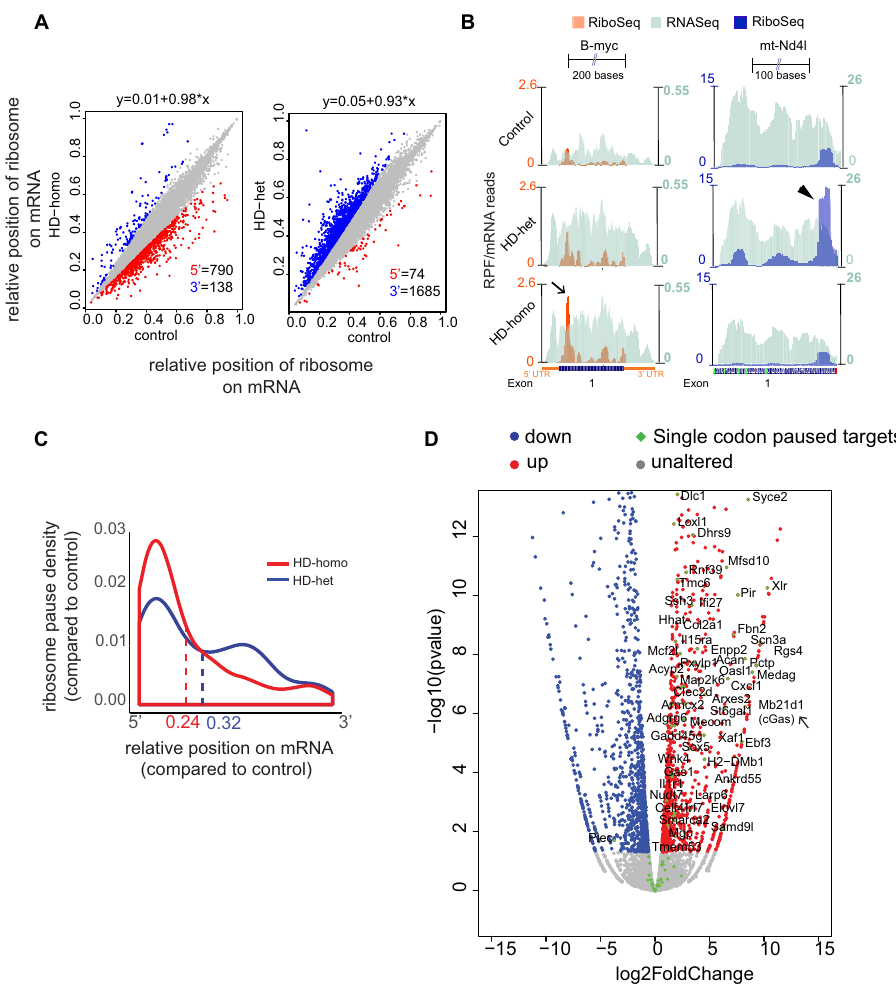
Fig. 8 Analysis of 5 ′ - and 3 ′ -end ribosome occupancy and single-codon pauses in HD cells. A Each dot represents the mean center ribosome density score of the same transcript in HD cells vs control cells ( n = 3). Red dots represent transcripts with higher 5 ′ ribosome occupancy in HD cells vs control cells. Blue dots represent transcripts with higher 3 ′ ribosome occupancy in HD cells vs controls. The axis indicates the relative position of the ribosome on the mRNA transcript. B Graphs showing the overlay of Ribo-Seq (RPF)/mRNA-Seq reads for B-myc and mt-ND4I , gene obtained from UCSC browser. C Pause density plot showing the distribution of common paused codons (found among three replicates of HD cells versus control cells) over their corresponding mRNAs. Numbers showed at the bottom represent the average of relative positions of paused codons in HD-homo (red) and HD-het (blue) cells. D Volcano plot from Fig. 4B representing changes in gene expression levels of ribosome-bound mRNAs in HD-homo cells (vs control cells) after ribosome run-off assay, showing single-codon paused targets (green). mRNA transcripts with absolute log2 fold change >0.3 and FDR-corrected P value <0.05 are shown with red (up, increased polysome binding, log2FC> 1), blue (down, decreased polysome binding, log2FC< 1), gray (unaltered, no difference in polysome binding). Statistical testing was done using DESeq2 with a two-tailed Wald test and adjusted for multiple comparisons using the procedure of Benjamini –